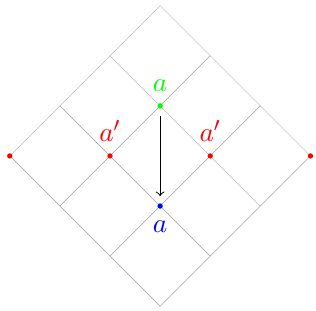
Figure 12 . The Hodge-Deligne diamond of type I a with its decomposition into primitive parts (4.38). The action of N (cid:0) are labelled by arrows, and we use colours to highlight the primitive 1 subspaces P 3 ( N (cid:0) ), P 4 ( N (cid:0) ) and their images under the action of N (cid:0) . Since the two sl (2)-triples 1 1 1 are commuting, the primitive subspace P 3 ( N (cid:0) ), P 4 ( N (cid:0) ) and their images under N (cid:0) are preserved 1 1 1 by N (cid:0) . 2